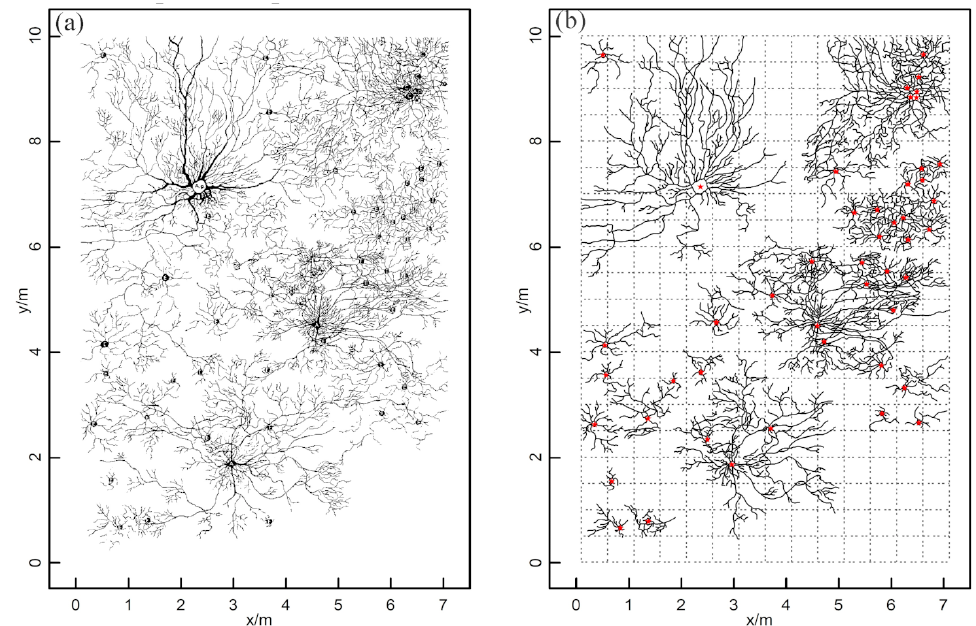
Figure 5. Simulated reference data: ( a ) the original reference data from an existing study [16] ; ( b ) the processed root distribution map used to simulate roots that could be detected by GPR surveys. The dotted lines represent GPR survey lines with a 50 cm interval. The red stars represent the shrubs’ centers.